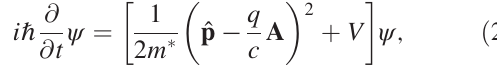
Fig. 3. The potential well V ð z Þ is special, not only because of its reflectionlessness but also for the existence of a bound state at the bottom of the potential well with zero energy in the z direction.